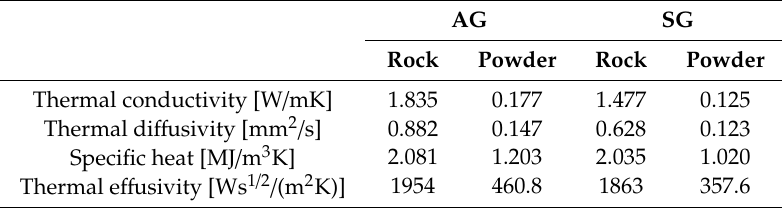
Table 5. Thermal characteristics of AG and SG rock and powder